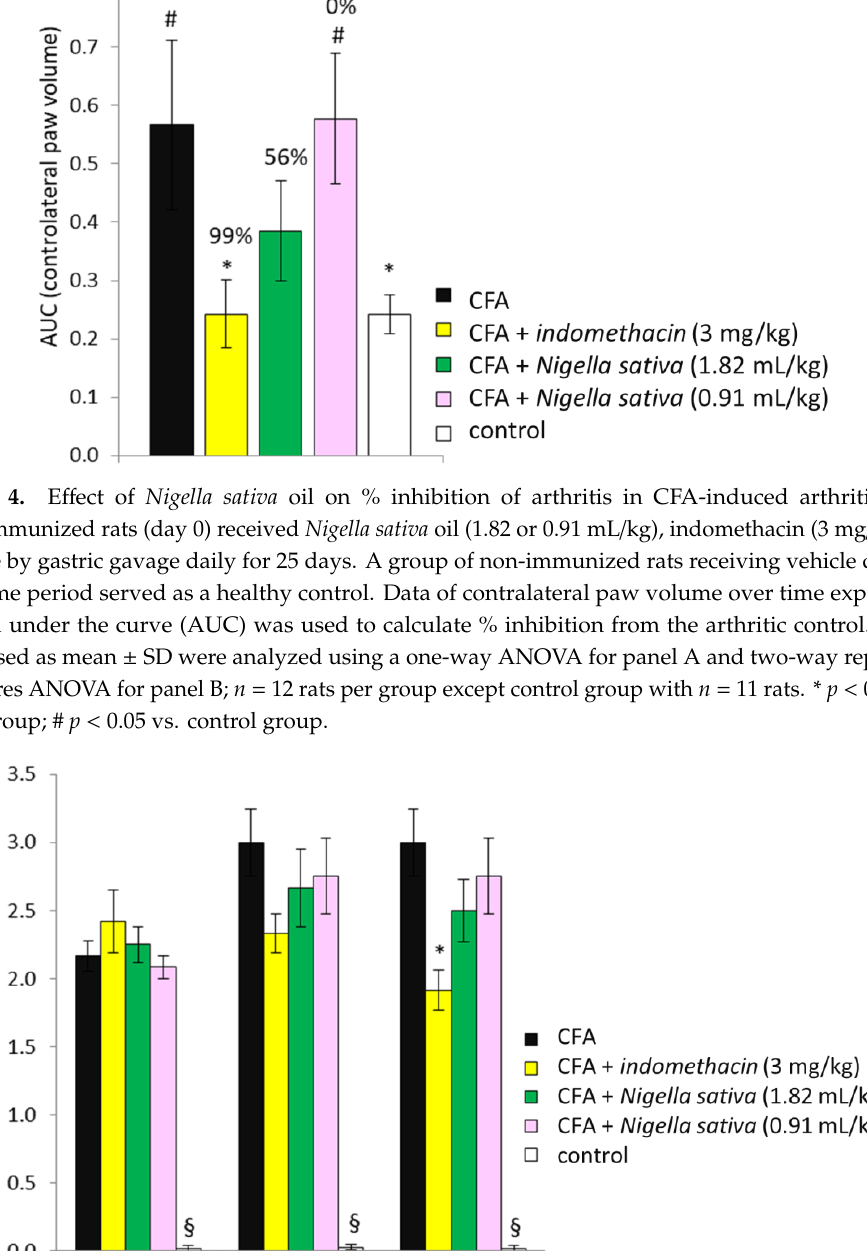
Figure 5. Effect of Nigella sativa oil on the arthritis score in CFA-induced arthritic rats. CFA- immunized rats (day 0) received Nigella sativa oil (1.82 or 0.91 mL/kg), indomethacin (3 mg/kg) or rats (day 0) received Nigella sativa oil (1.82 or 0.91 mL / kg), indomethacin (3 mg / kg) or vehicle by